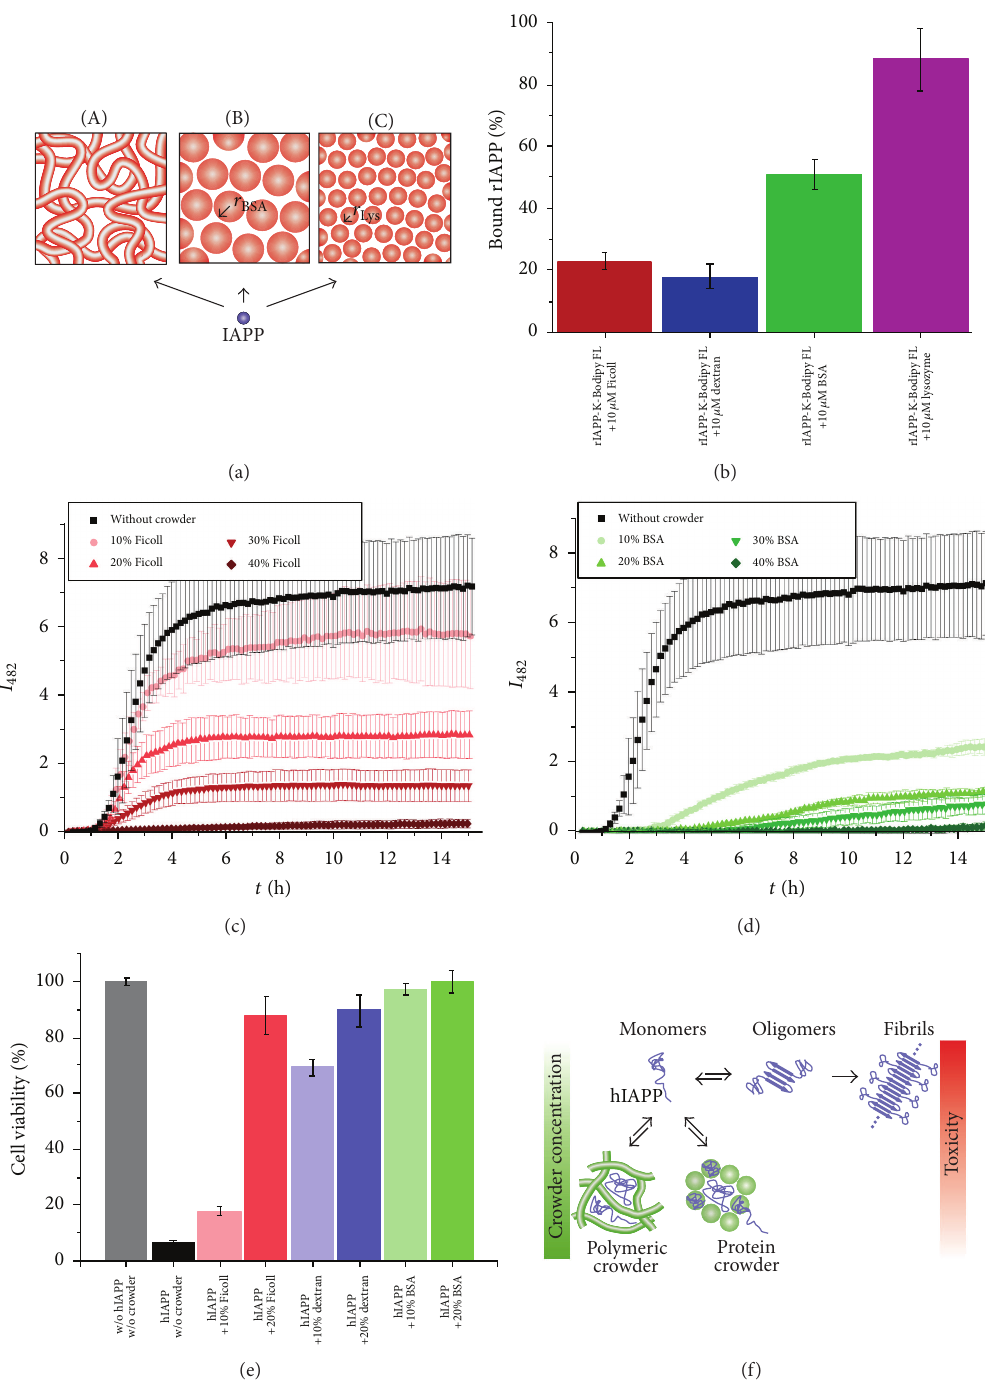
Figure 7: Suppressive effect of macromolecular crowding on hIAPP aggregation and cytotoxicity. (a) Schematic illustration of the excluded volume effect caused by different polymer and protein crowding agents (A: Ficoll and dextran, B: BSA, C: lysozyme). (b) Moderate to strong interaction between ratIAPP and the crowding agent at equimolar concentration, as analyzed from FCS measurements, affect the aggregation kinetics of 10 𝜇 M hIAPP differently as measured by ThT fluorescence spectroscopy (c, d). In addition, a crowder concentration dependent decrease of the fibril amount formed is observed. (e) The effect of macromolecular crowding favors the formation of nontoxic off-pathway hIAPP species. (f) In summary, with the results from complementary AFM and ATR-FTIR studies, two competing reaction pathways of hIAPP aggregation under crowding conditions are revealed. The horizontal path shows the well-known hIAPP aggregation mechanism from a naturalmonomericdisorderedstructureviaformationofnucleiandoligomerstofibrilaccumulation. Thecompetingcrowdertypedependent stabilization of nontoxic, off-pathway and globular hIAPP species is shown in a vertical path. Adapted and modified from